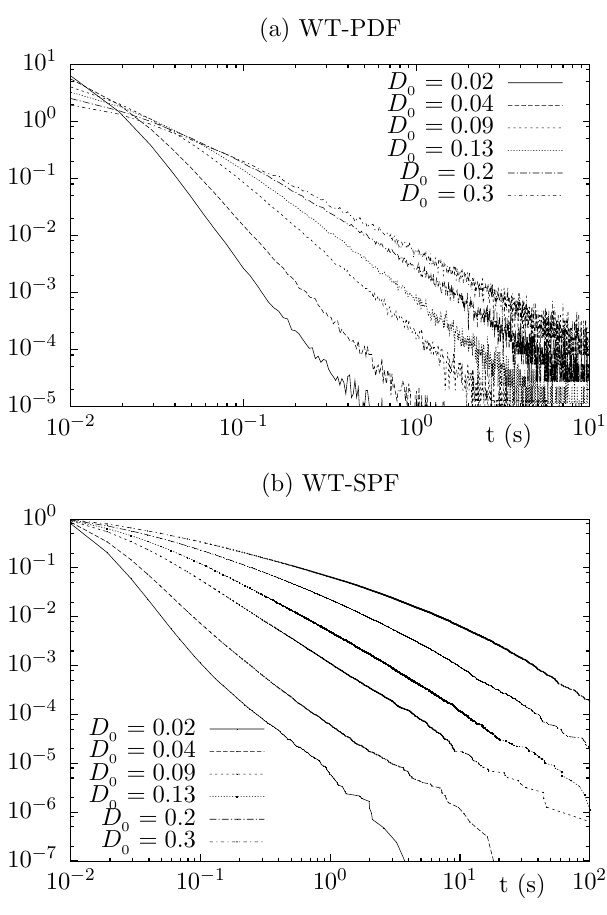
Fig. 4. Distribution of Waiting Times ( U x component): (a) proba- bility density; (b) survival probability.